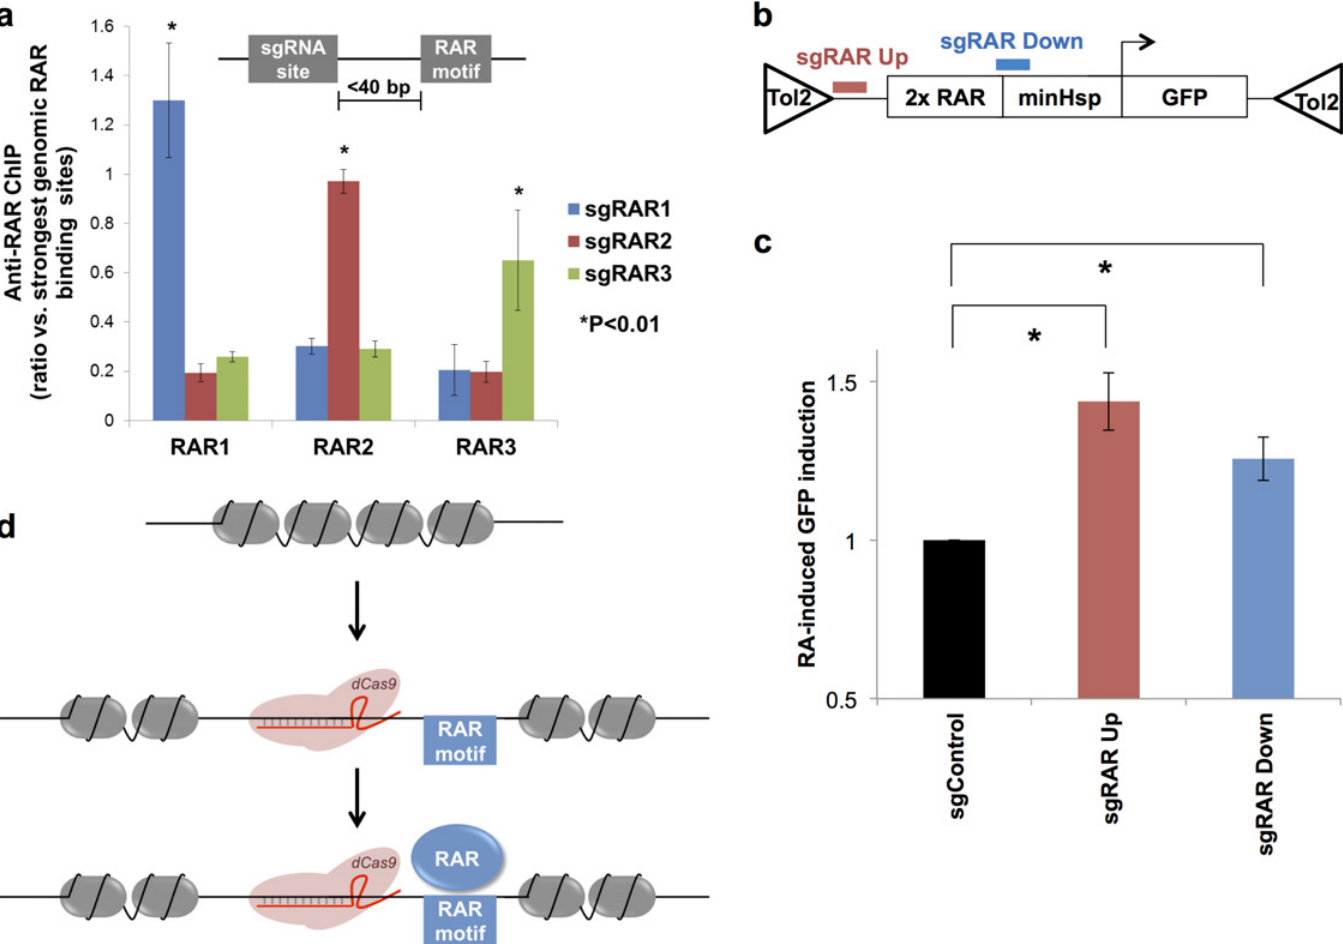
Fig 2. dCas9 chromatin opening enables adjacent RAR binding and RA-dependent gene activation. a . Anti-retinoic acid receptor (RAR) ChIP followed by qPCR at three loci (RAR1-3, x-axis) in the presence of sgRNAs targeting each locus (blue, red, and green). ChIP-qPCR values are normalized to the average of two of the strongest genomic RAR binding sites. Three replicates were performed for all experiments, and a two-tailed Student ’ s t-test was used to calculate significance, and values with P < 0.01 are denoted with a * . b. The Tol2 transposon-based reporter system involves stable integration of a 2x RAR motif, a minimal promoter, and GFP. dCas9 was recruited through sgRNA sequences upstream (sgRAR Up, red) or downstream (sgRAR Down, blue) of the 2x RAR motif. c . Average flow cytometric GFP induction by RA in the presence of control sgRNA (black), sgRAR Up (red), or sgRAR Down (blue) sgRNAs. d . dCas9 is able to bind to sgRNA sequences in inaccessible chromatin and induce accessibility, which directly enables the settler factor RAR to bind to previously obscured